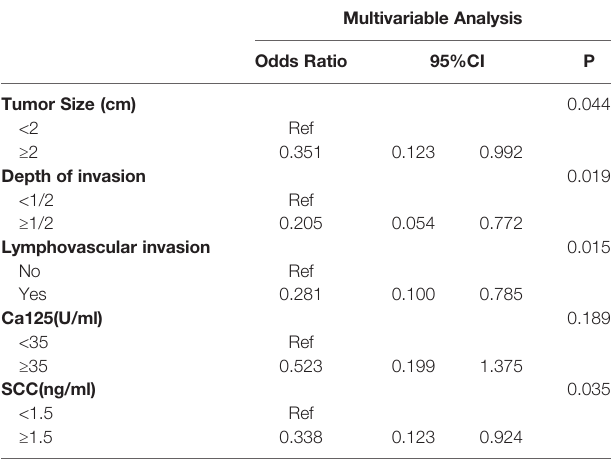
TABLE 2 | Multivariable Binary Logistic Regression Analysis of CC for the